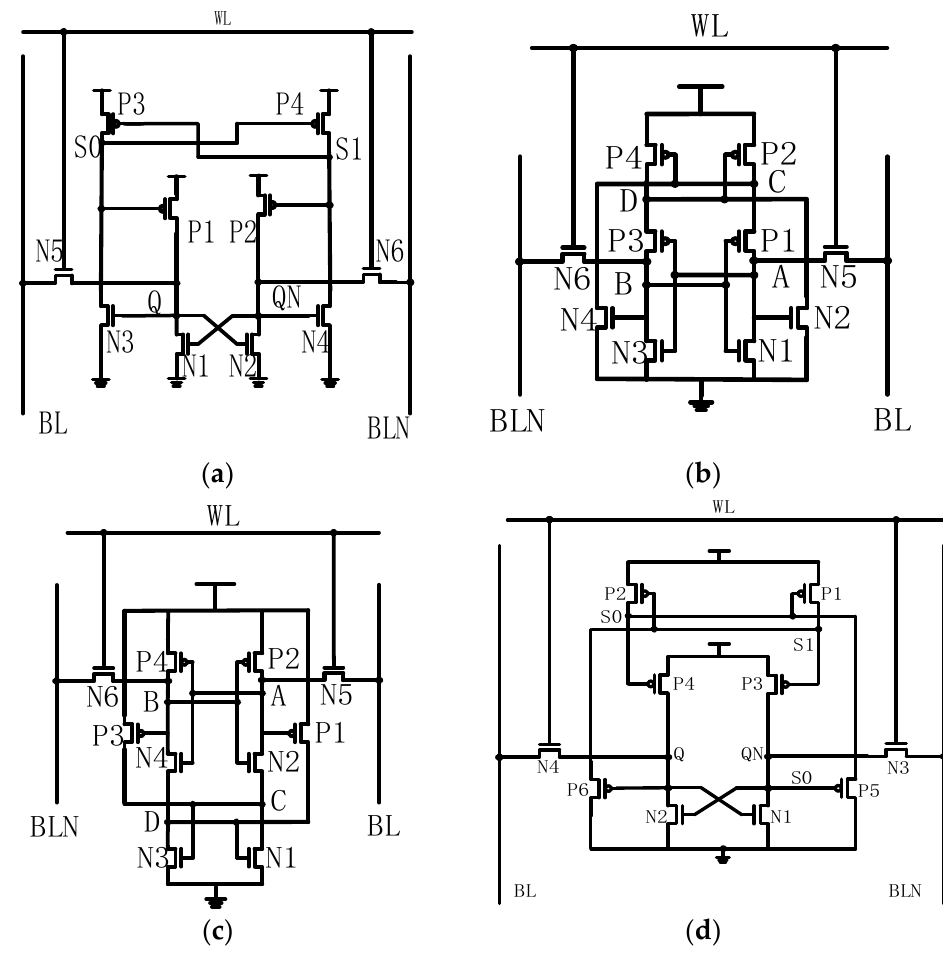
Figure 2. Hardened SRAM cells: ( a ) Quatro-10T; ( b ) PS10T; ( c ) NS10T; ( d ) RHBD10T. PP10T read/write simulation is shown in Figure 3. Write operations are performed at 100 ns and 300 ns respectively, and read operations are performed at 180 ns and 430 ns, respectively. The read operation causes interference to the logic “0” potential node, but because the gate of the two PMOS devices is connected to the logic “0” node, the voltage rise of the node can only turn off the two PMOS devices at worst, without changing the storage state of the other